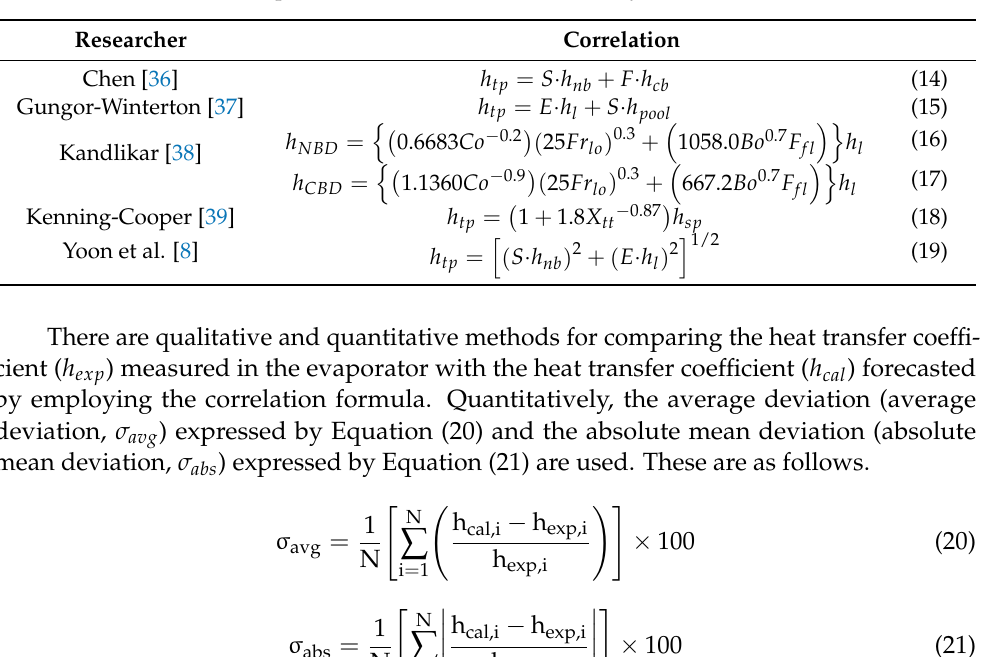
Table 7. Correlations for evaporation heat transfer determined by several researchers.